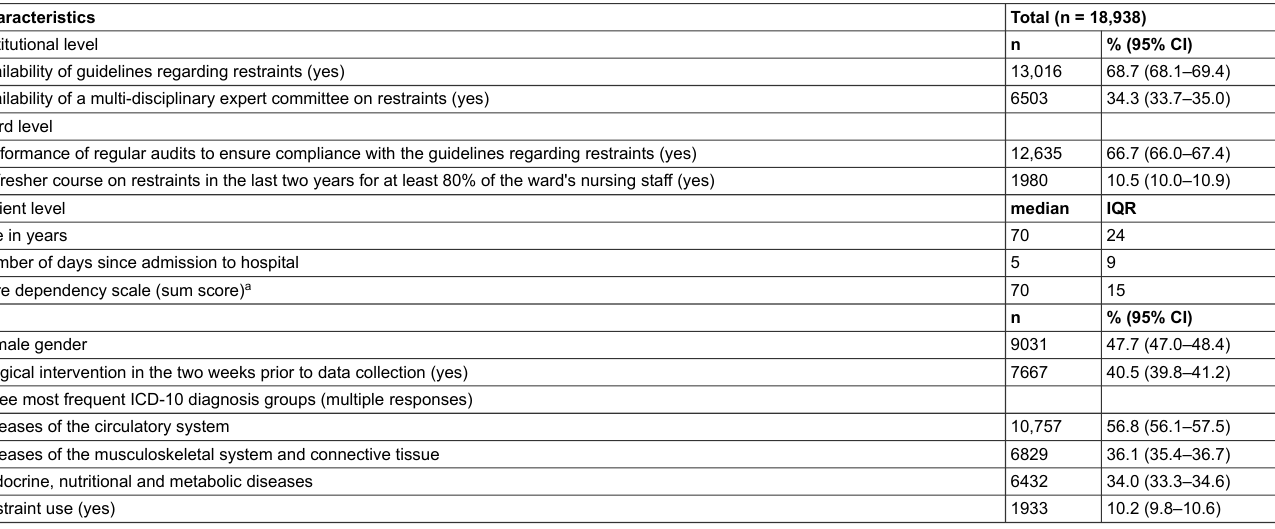
Table 1: Sample description.